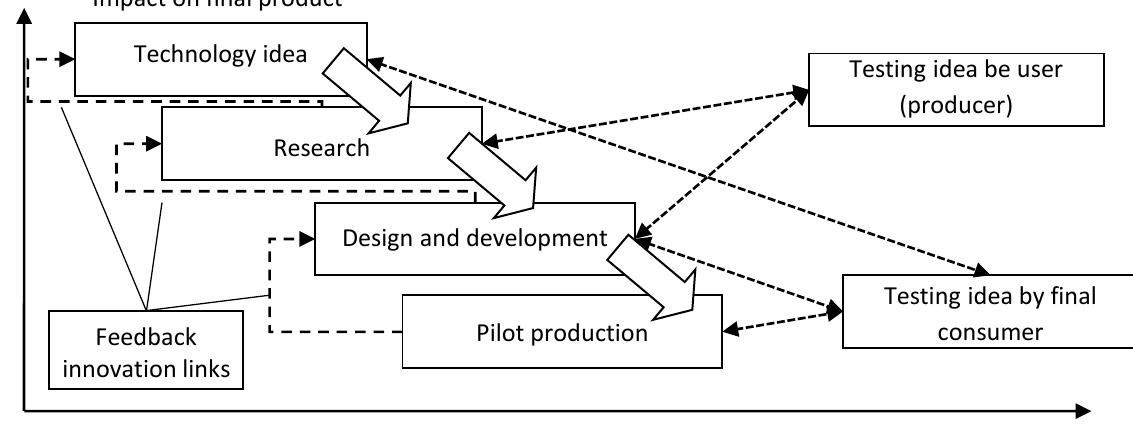
Figure 1. Startup methodology in high technologies transfer (developed by authors)